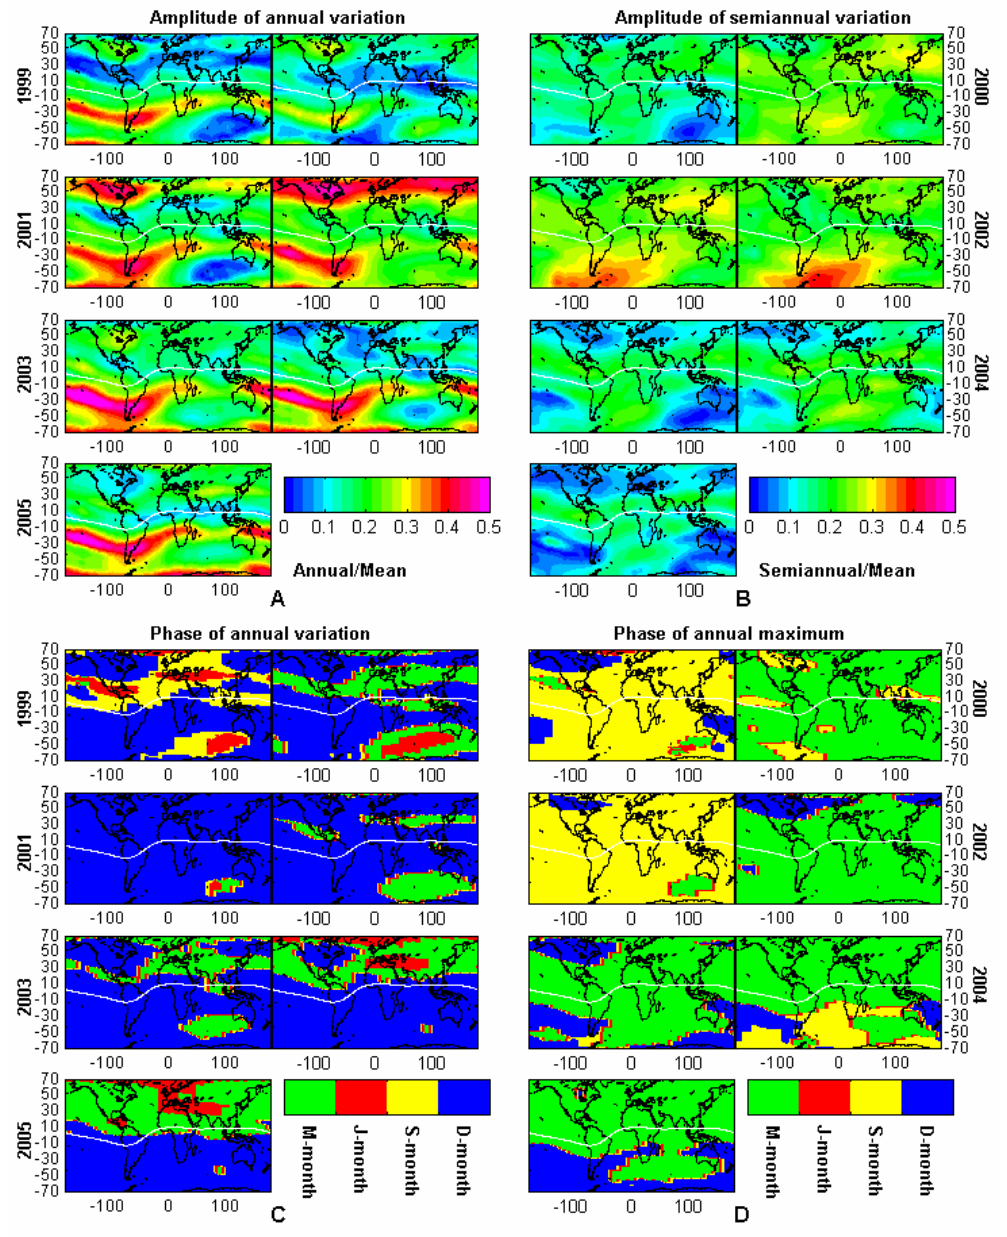
Fig. 6. Global distributions of the amplitudes of the annual and semiannual components (A, B) and the phase of the annual variation (C) , and the position of the existing maximum value (D) and the amplitude of the equinox asymmetry. The white line denotes the magnetic equator (E) . x and y-axes are the geographic longitude and latitude and the white line is the dip